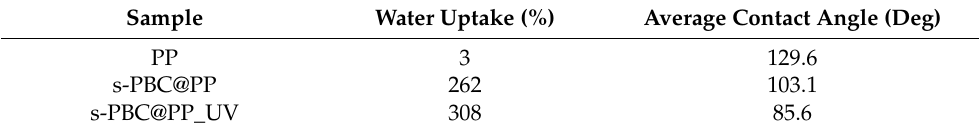
Table 1. Water uptake (%) and contact angle measured for PP, s-PBC@PP, and s-PBC@PP_UV samples.